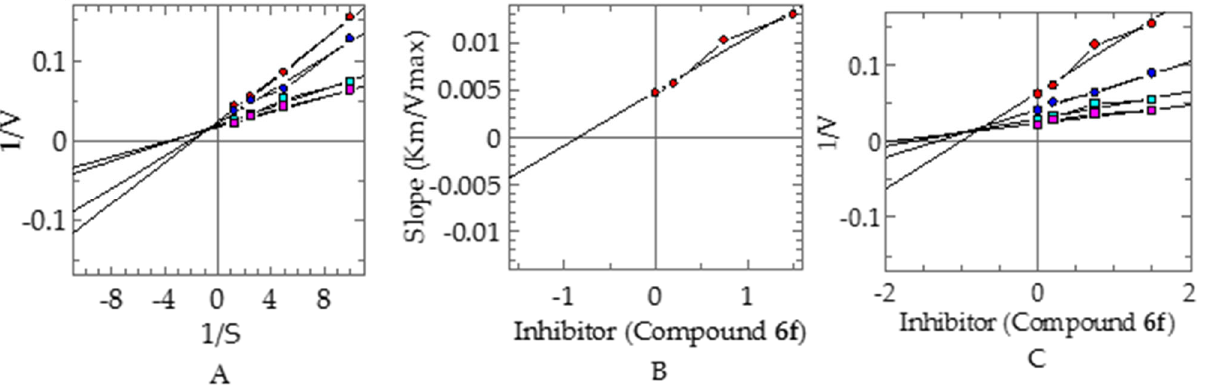
Figure 3. Mode of inhibition of α -glucosidase by compound 6f : ( A ) Lineweaver–Burk plot of reciprocal of rate of reaction (velocities) vs. reciprocal of substrate p-nitro phenyl- α -D-glucopyranoside in the absence of ( ■ ), and in the presence of 1.50 ( ● ), 0.75 μ M ( ● ), and 0.200 μ M ( ■ ) of compound 6f . ( B ) Secondary replot of Lineweaver–Burk plot between the slopes of each Lineweaver–Burk plot vs. different concentrations of compound 6f . ( C ) Dixon plot of reciprocal of rate of reaction (velocities) vs. different concentrations of compound 6f .